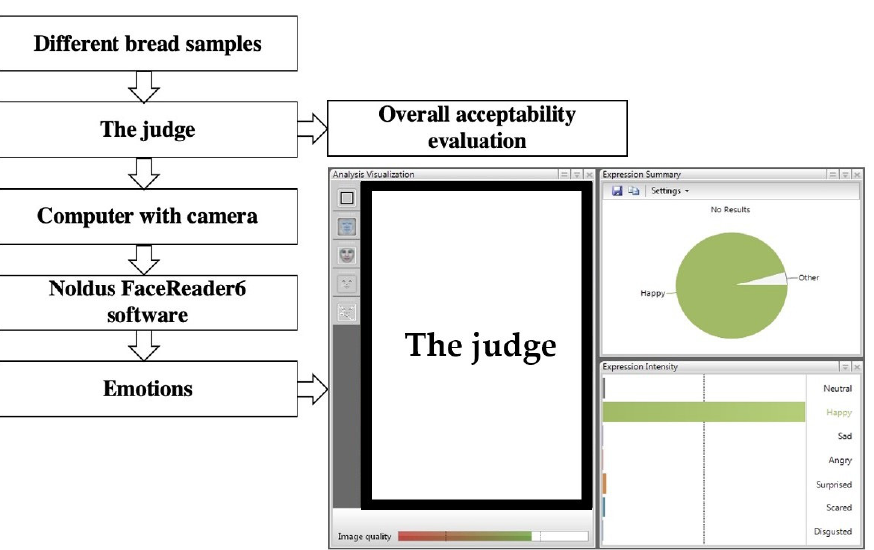
Figure 1. Analysis of the emotions induced by the bread using FaceReader 8 software (Noldus Information Technology, Wageningen, The Netherlands) and further scoring the eight emotion patterns: neutral, happy, sad, angry, surprised, scared, disgusted, and